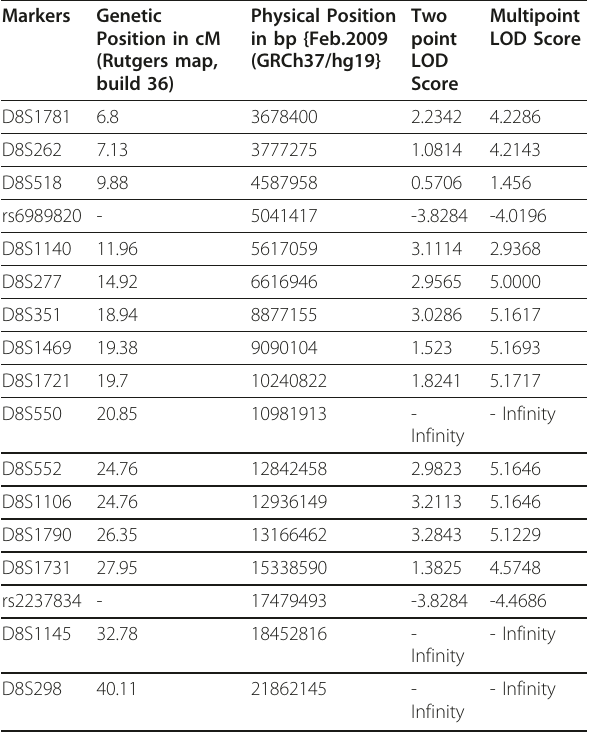
Table 2 Two point and multipoint LOD score